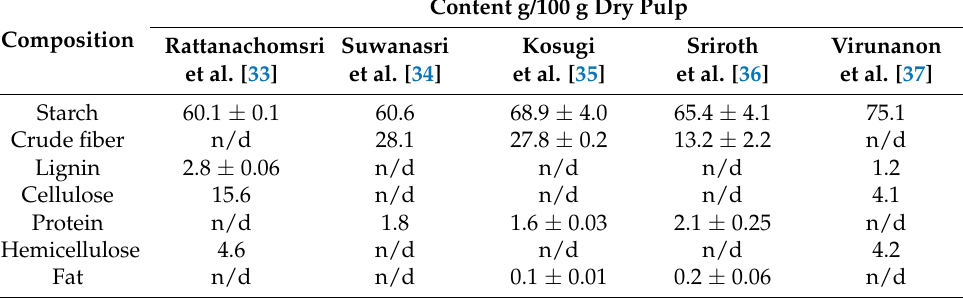
Table 1. Pulp content of cassava.